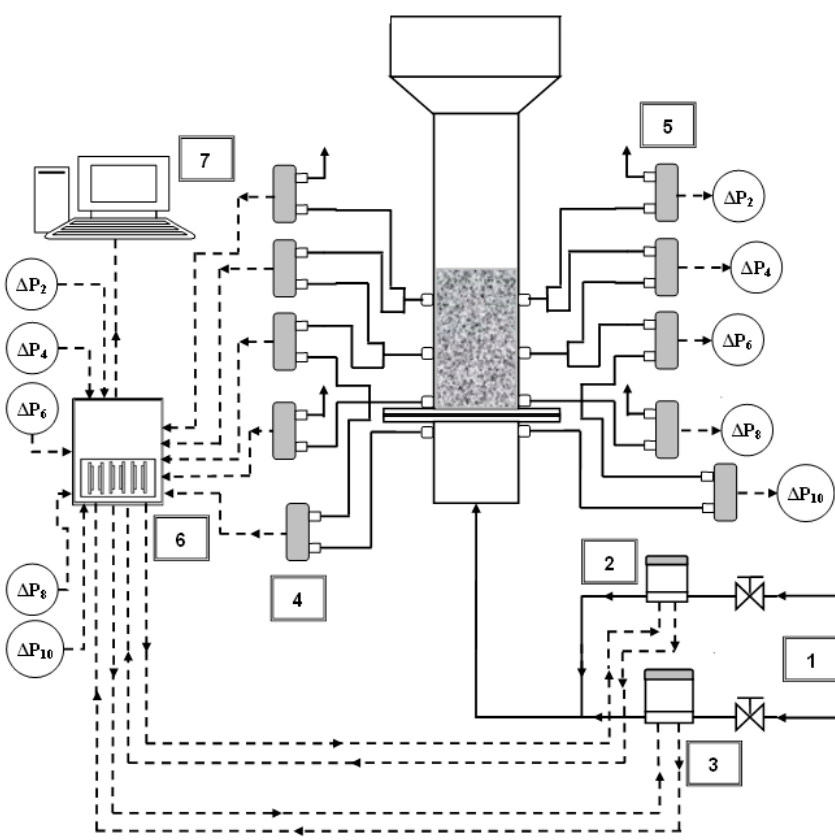
Figure 1. Schematic diagram of the experimental set-up. ( 1 ) Air supply; ( 2 ) low range mass flow controller; ( 3 ) high range mass flow controller; ( 4 ) pressure transducers ( ∆ P 1 , ∆ P 3 , ∆ P 5 , ∆ P 7 , and ∆ P 9 on left side of the column); ( 5 ) pressure transducers ( ∆ P 2 , ∆ P 4 , ∆ P 6 , ∆ P 8 , and ∆ P 10 on the right side of the column); ( 6 ) data acquisition system; ( 7 ) computer with LabVIEW software.